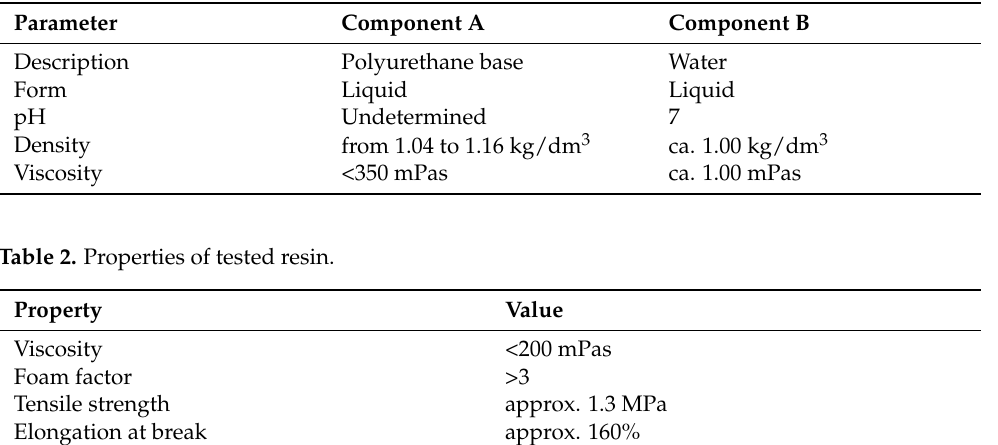
Table 1. Components of tested resin.